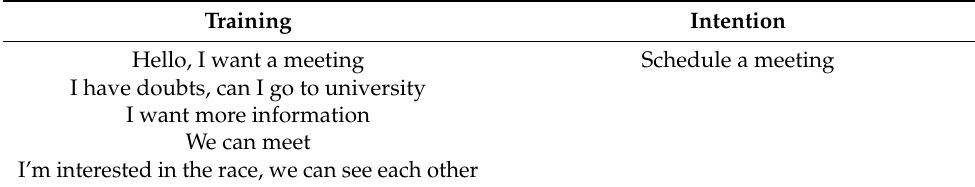
Table 3. Group of texts that can define one or more